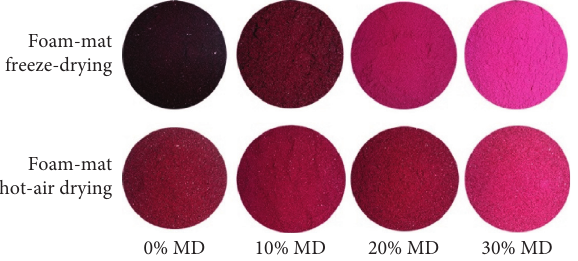
Figure 3: The color of foam-mat-dried instant beverage powders based on red beetroot extract; MD,